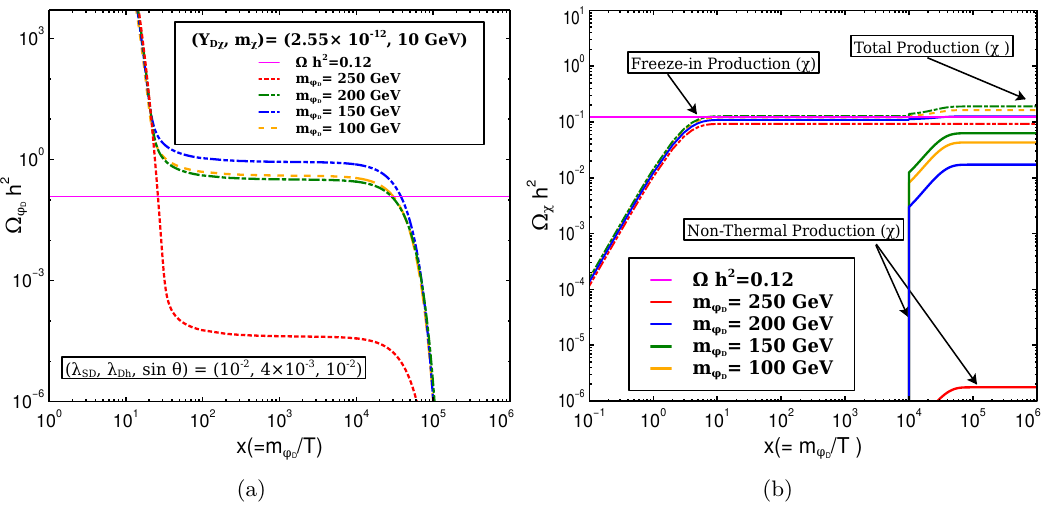
Figure 11 . Left panel: figure 11(a) shows the variation of Ω φ figure 11(b) shows the variation of Ω